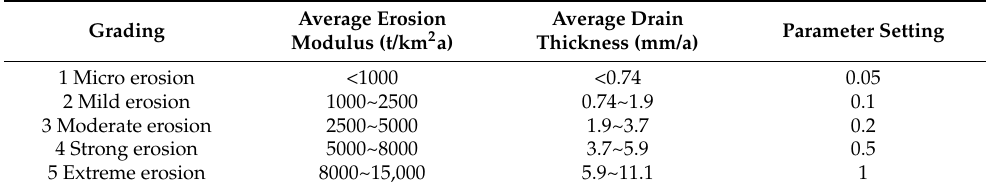
Table 1. Grading method of soil erosion intensity